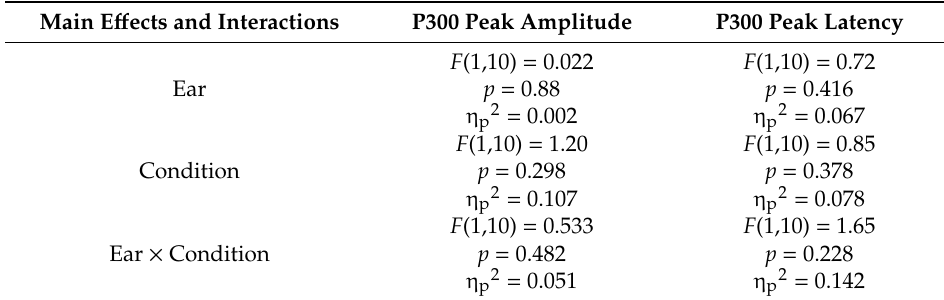
Table 7. Descriptive statistics of d’ (sensitivity), criterion and reaction times obtained in the active- discrimination condition (P300 task) without and with contralateral acoustic stimulation (CAS) in the two ears. SD = Standard Deviation.